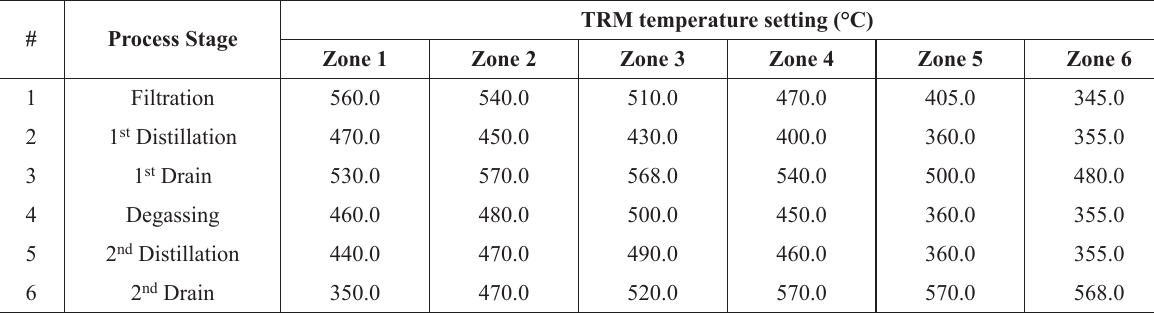
Table 1. Recommended TRM controller temperature settings for Te refinement process stages